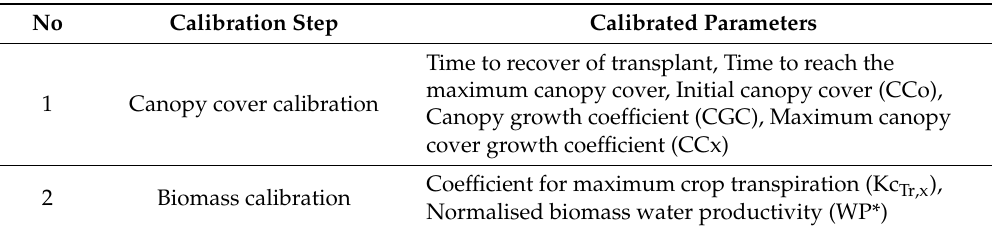
Table 3. Calibrated parameters of lettuce